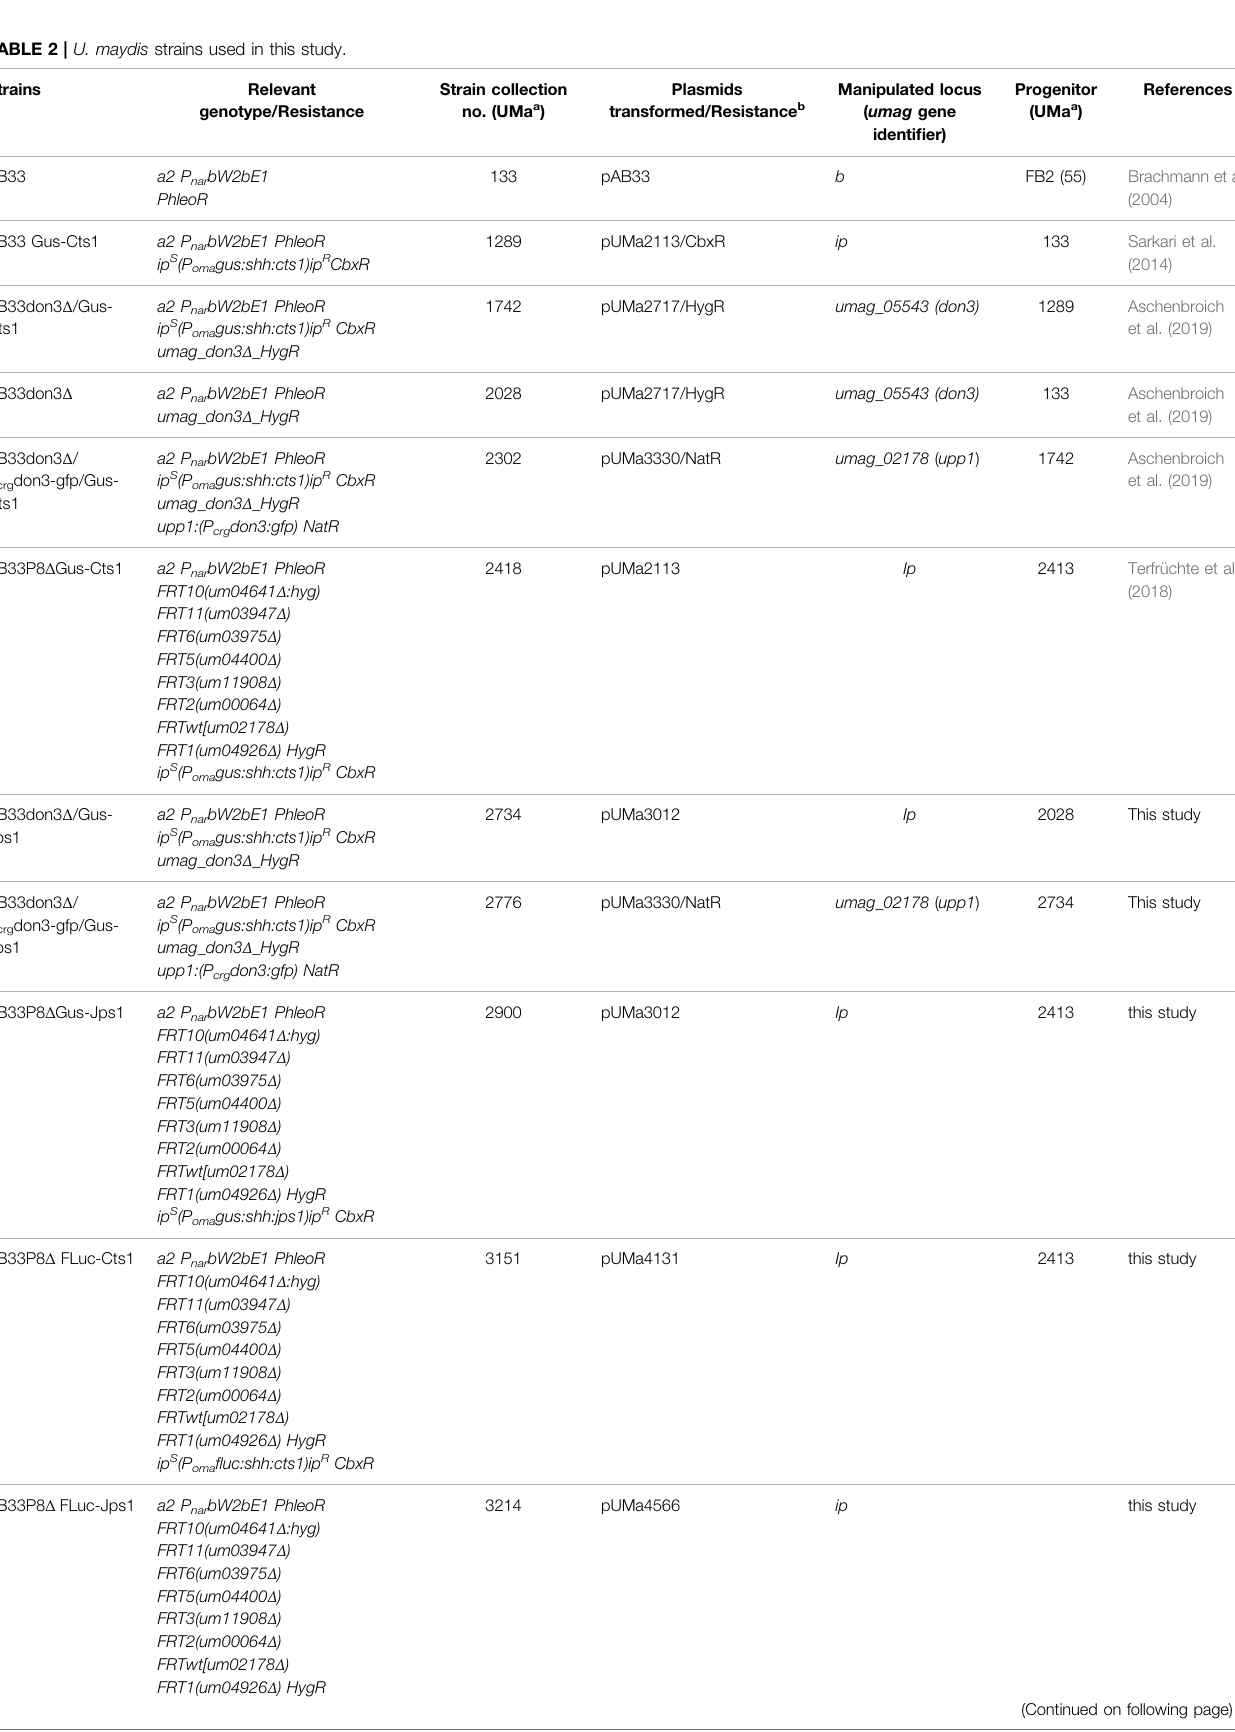
TABLE 2 | U. maydis strains used in this study.